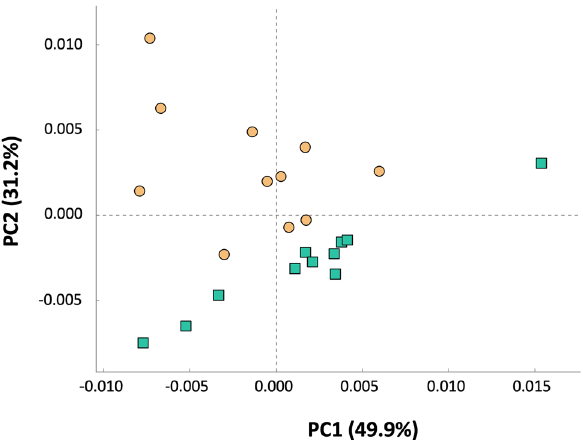
Figure 6. PCA of the functional pathway composition of each sample. Samples from piglets from vaccinated sows (vs-P group) are represented as green squares and samples from piglets from control sows (cs-P group) are represented as oranges